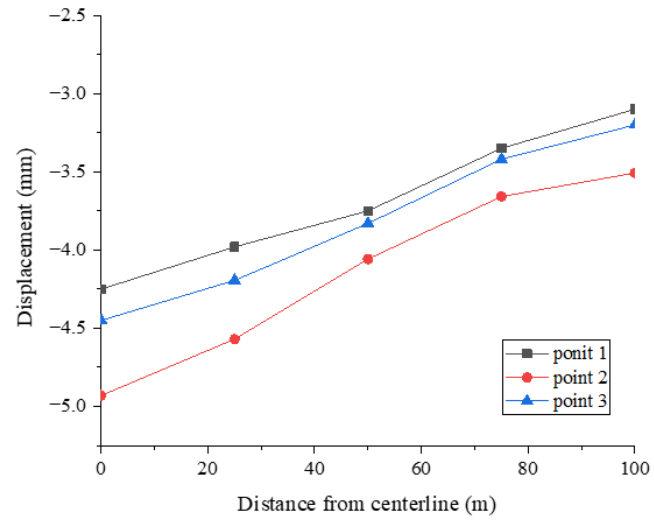
Figure 7. Variation curve of displacement at different monitoring points with the spacing of tunnel excavation surface.